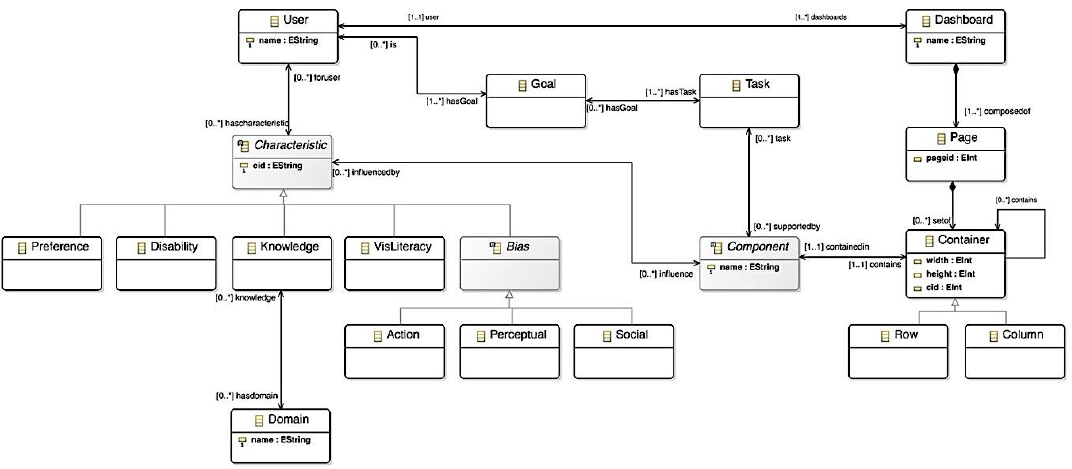
Figure 2. Overview of the dashboard meta-model, including the user, the layout, and the components. This image is available in high resolution at https://doi.org/10.5281/zenodo.3561320. Licensed under CC BY 4.0.